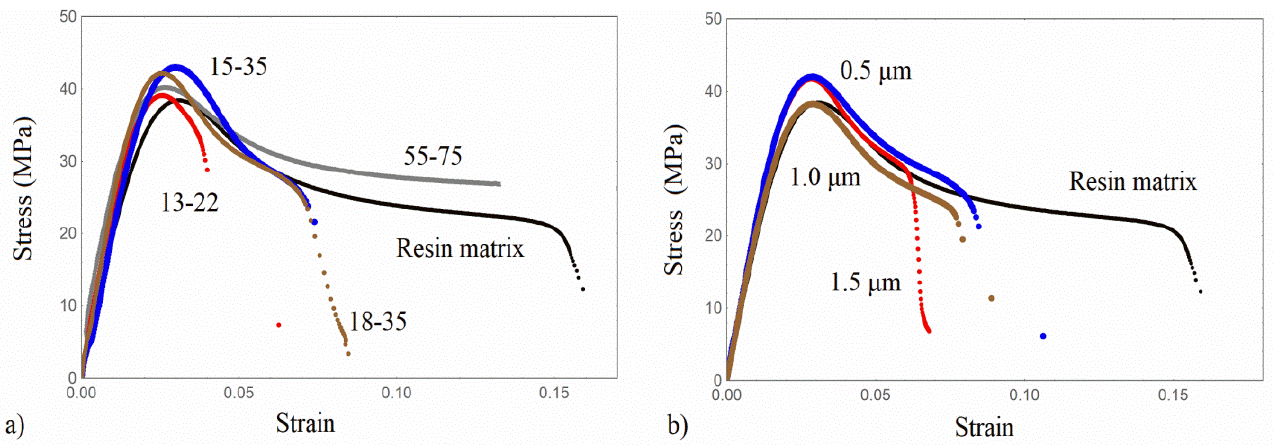
Figure 5. Tensile stress-strain curves of ( a ) PLA/silica nanocomposites, ( b ) PLA/silica micro-compo- sites.